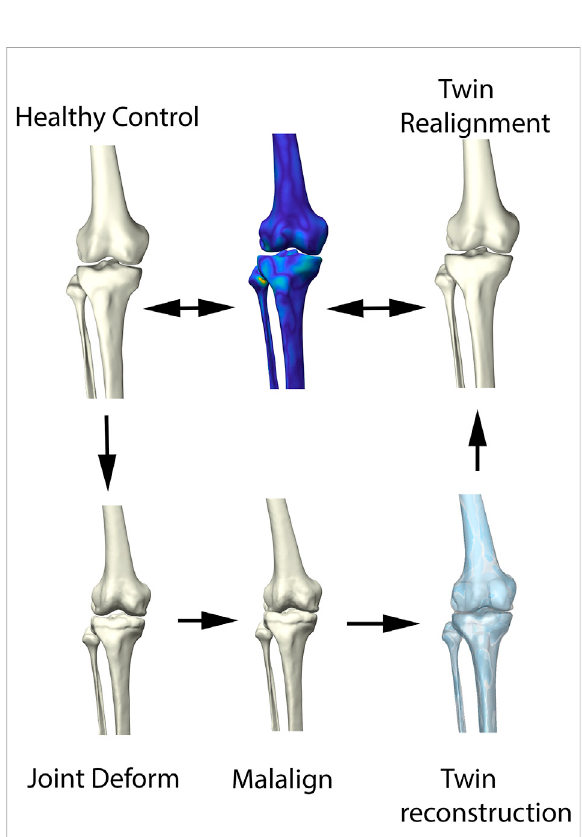
FIGURE 3 Visual representation of the synthetic validation